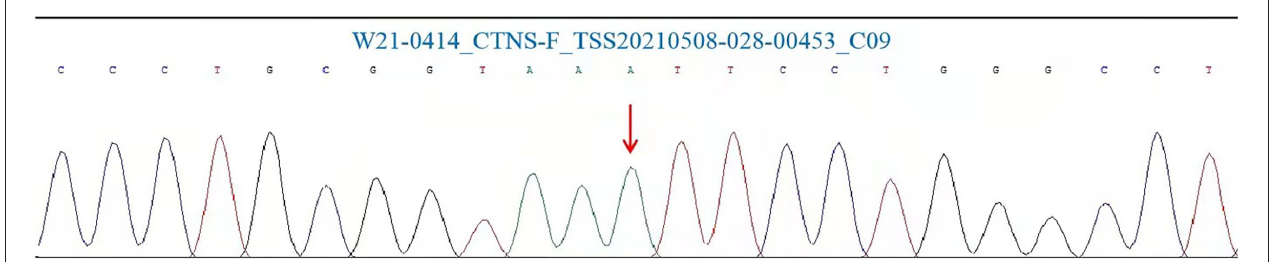
FIGURE 2 | CTNS mutation Sanger analysis results for the patient involved in this study. Polymerase chain reaction (PCR) and Sanger was performed in our test.